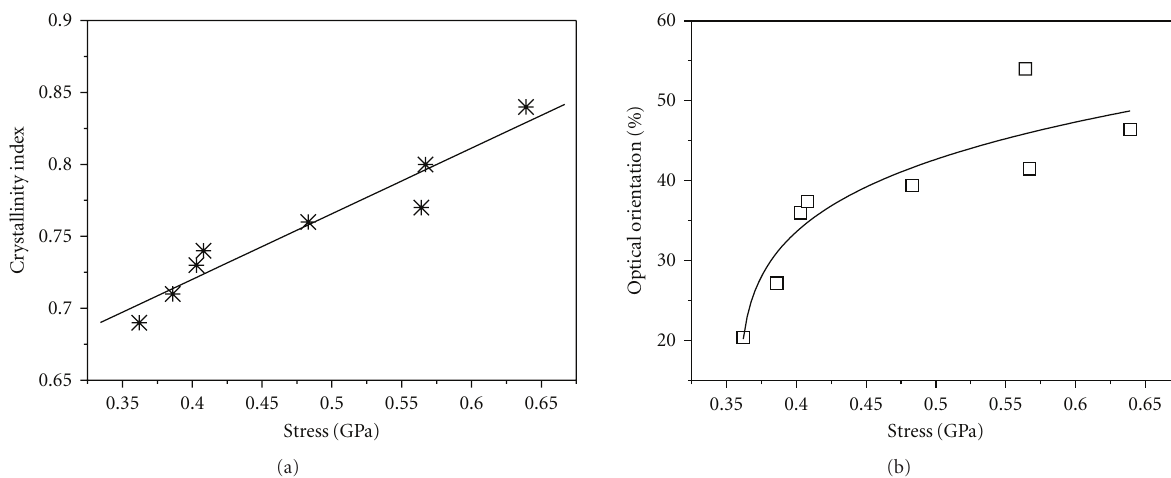
Figure 3: (a) Relation between crystallinity index and breaking stress of A. pernyi silks and (b) relation between optical orientation and breaking stress of A. pernyi